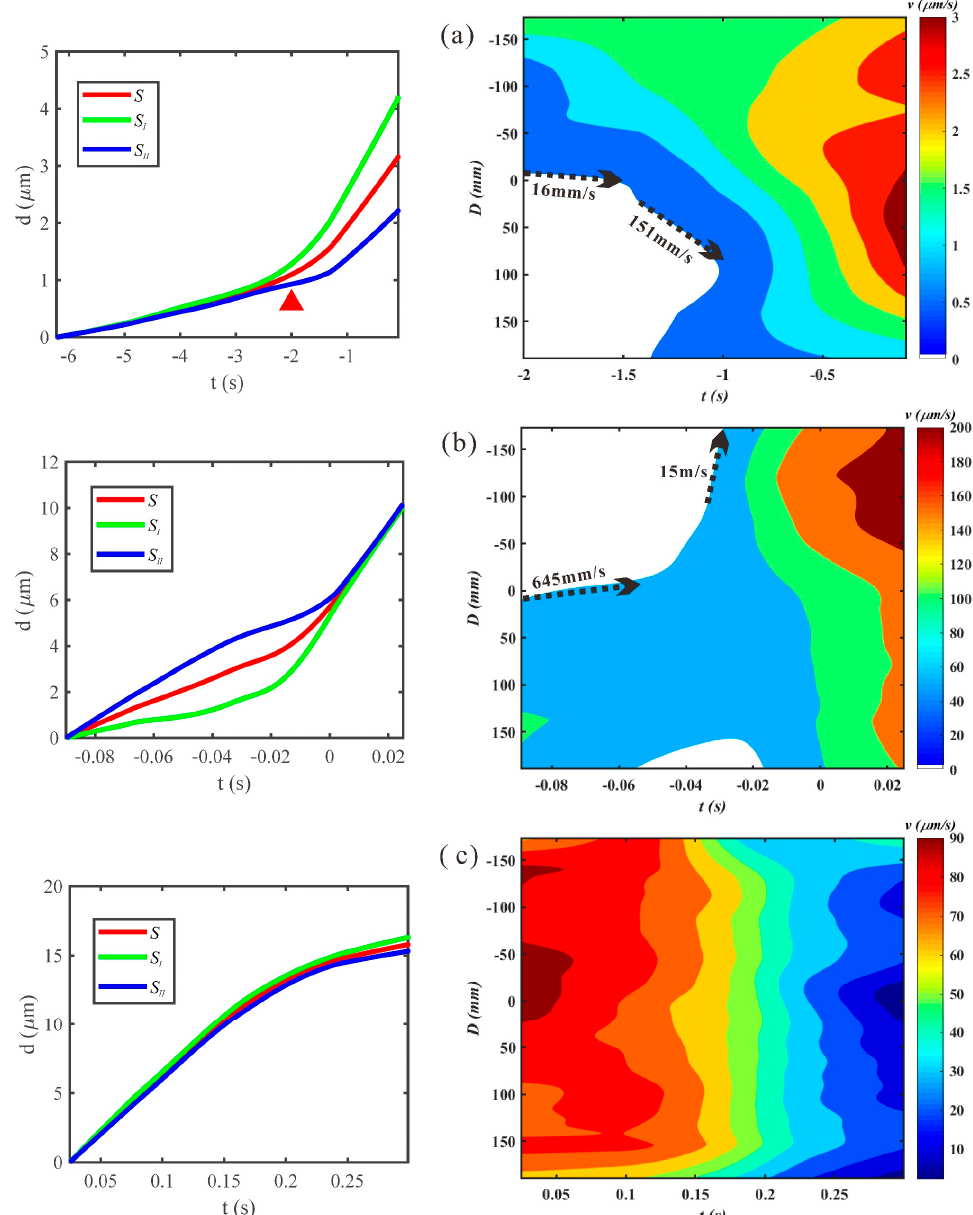
Figure 4. Spatiotemporal distribution of fault slips and slip velocity before and after the overall instability of event E1. The subgraphs on the left side show the change of the average slip of the whole fault ( S ), the segment S I ( S I ), and the segment S II ( S II ) with time. D = 0, D < 0, and D > 0 denote the fault bend point, the segment S I , and the segment S II , respectively. The subgraphs on the right side show the spatiotemporal distribution of the fault slip velocity ( v ). The black dotted arrows and numbers represent the directions and propagation speeds of ruptures, respectively. Note that the time span of the left subgraph is larger than that of the right subgraph in ( a ). The red triangle in the left subgraph in ( a ) denotes the beginning of the obvious slip velocity that can be observed; spatiotemporal evolution of slip velocity after which is shown in the right subgraph in ( a ). The time spans of the left and right subgraphs in ( b ) and ( c ) are consistent. The time axes from ( a ) to ( c ) are continuous. The common timing point of the data from the DIC method and strain gages is set zero for each stick-slip event. Accordingly, time before and after the common timing point is negative and positive, respectively.